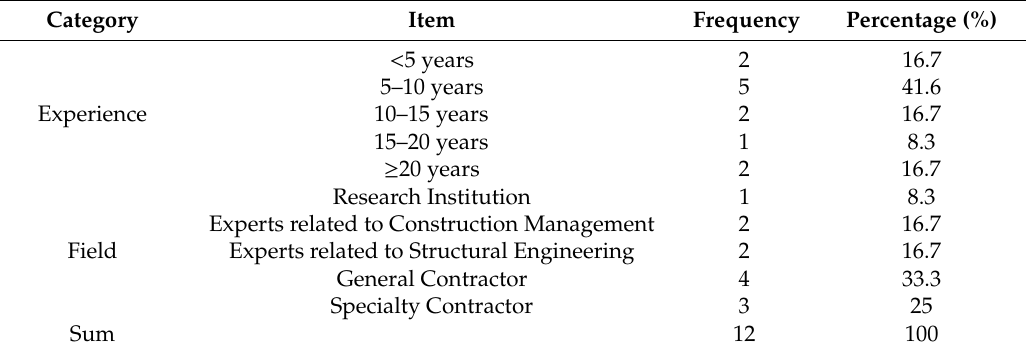
Table 6. Composition of the experts.